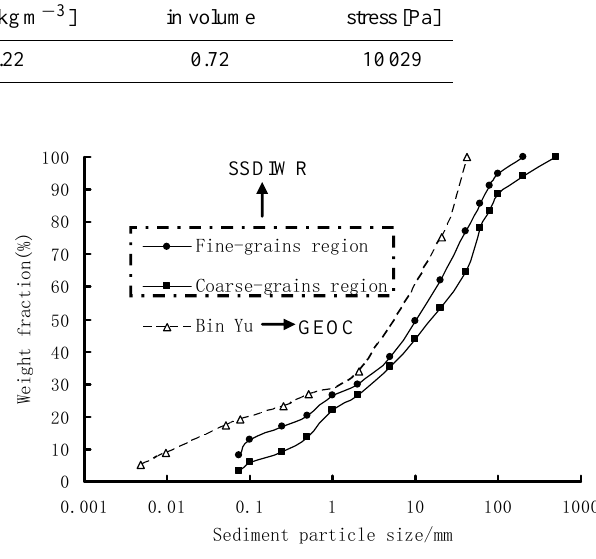
Fig. 3. Grain-size distribution of Figure 3. Grain-size distribution of deposition